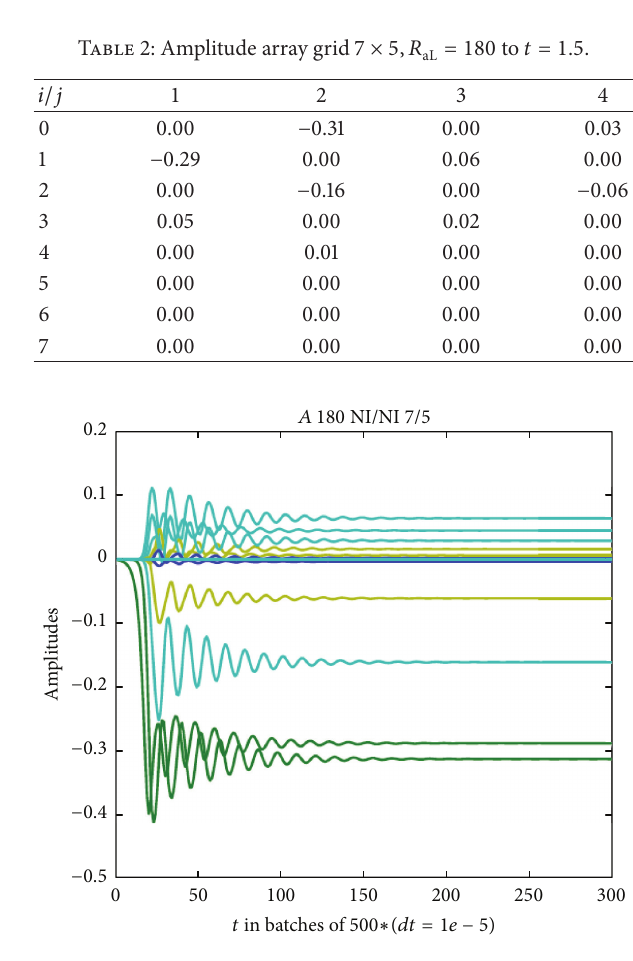
Simulations in a 9×7 grid are a little more unstable than in the 7×5 grid. Fluctuating periodic flow is reached at 𝑅 and can be maintained until 𝑅 average amplitude array of 𝑅